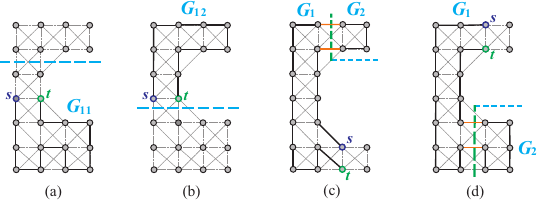
Figure 20. A longest ( s , t ) -path under that a (cid:62) 2 and c , d (cid:62) 2 for ( a , b ) (UB3) holds, and ( c , d ) (UB4) holds, where the bold lines indicate the constructed longest ( s , t )